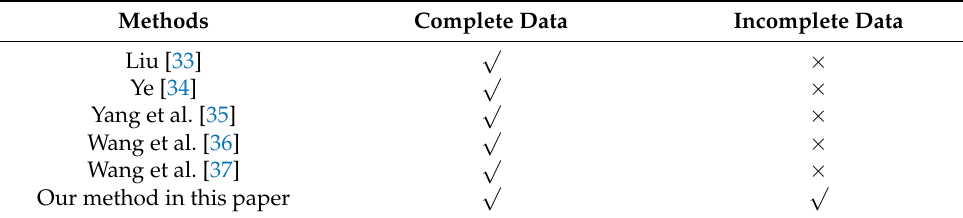
Table 10. Different methods for three-way fuzzy information. Methods